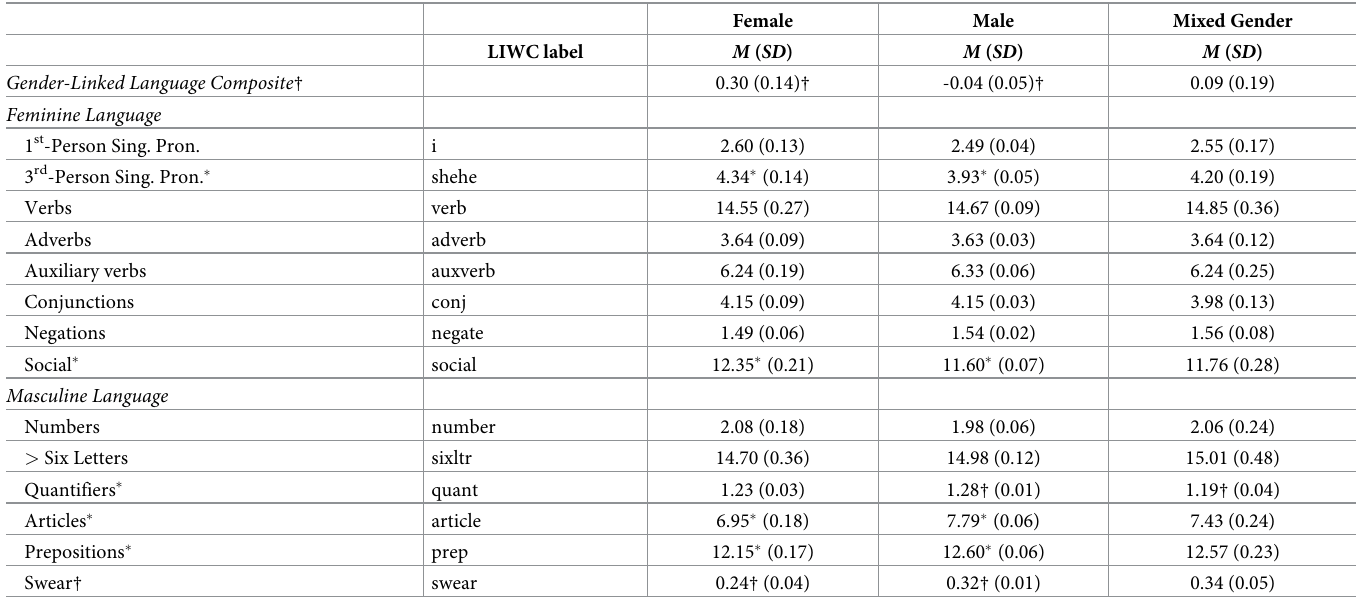
Table 2. Descriptive statistics for language use in films across female, male, and mixed gender writers.